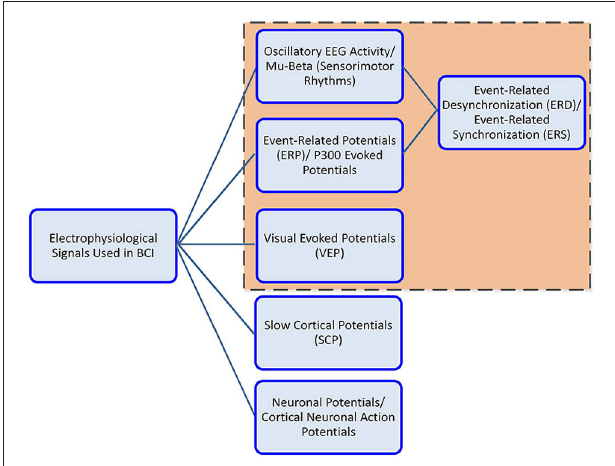
FIGURE 3 | Electrophysiological signals used in BCI controlled wearable LL and assistive-robot devices.